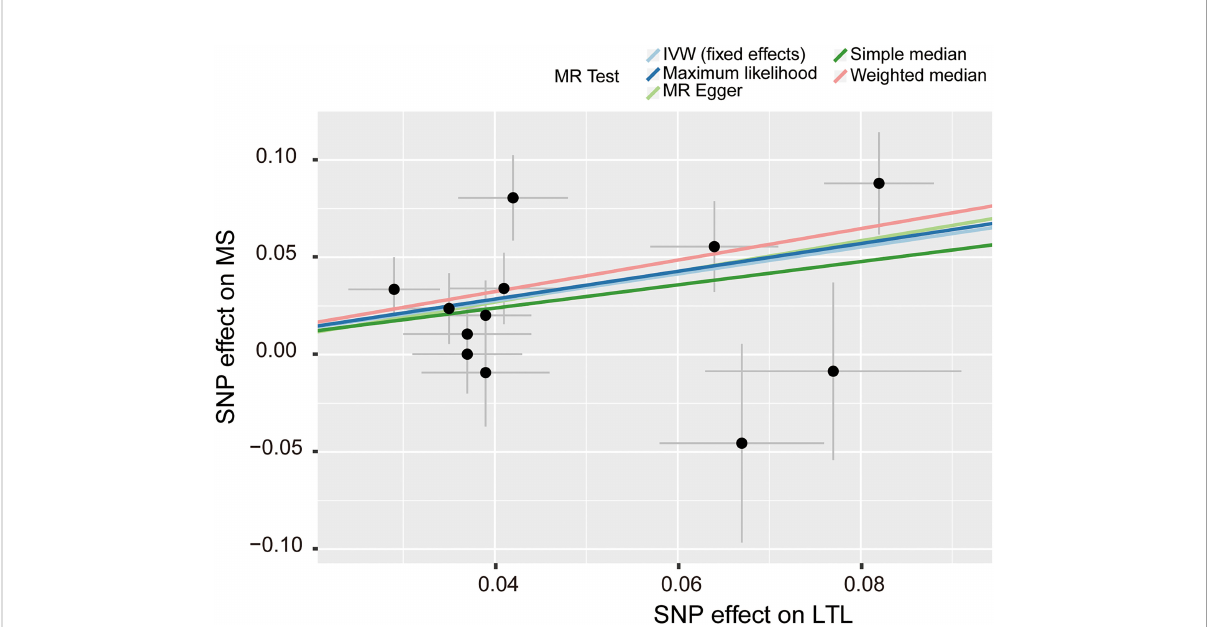
FIGURE 3 Scatter plot of the effect size and 95% CI of each SNP on LTL and MS risk. The horizontal axis re fl ects genetic effect of each SNP on LTL. The vertical axis represents the genetic effect of each SNP on MS risk. SNP, single-nucleotide polymorphism; MS, multiple sclerosis; LTL, leukocyte telomere length; IVW, inverse variance weighted.